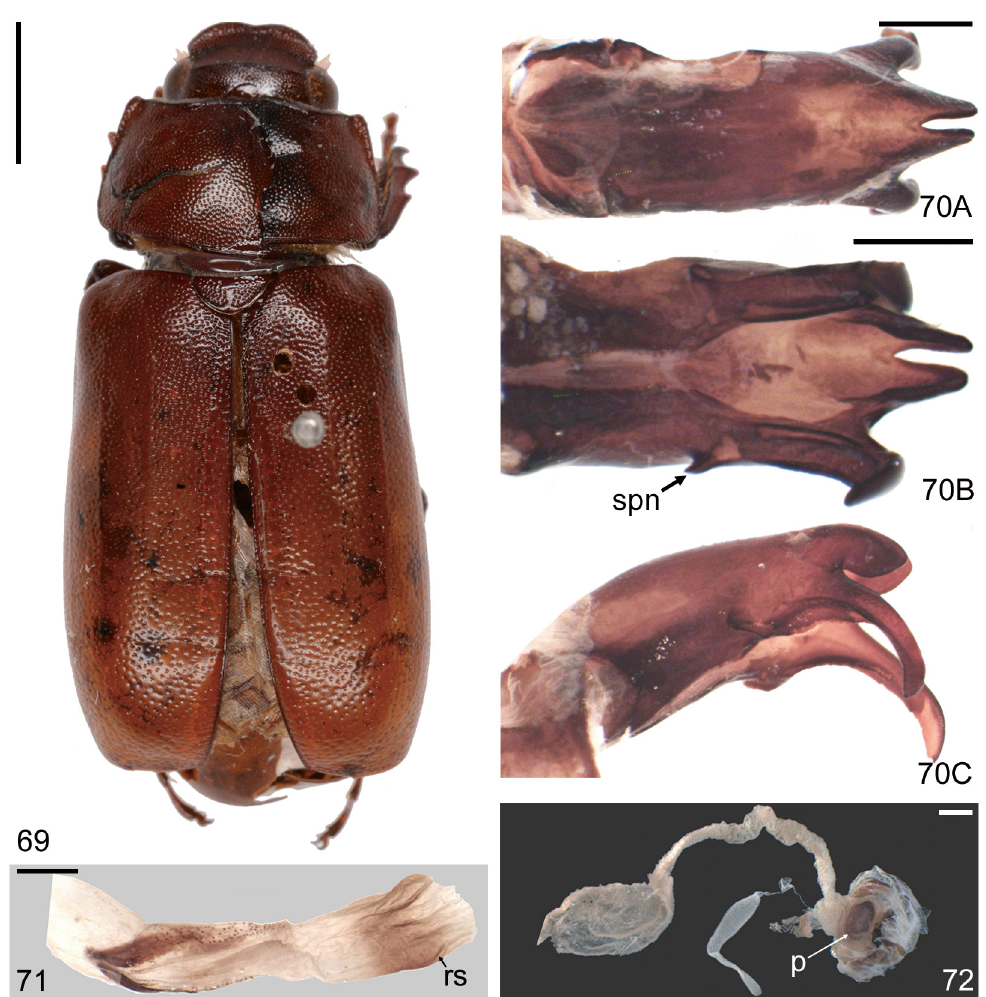
69 . Habitus in dorsal view. 70 . Parameres in dorsal (A), ventral (B) and lateral (C) views. 71 . Endophallus and temones in dorsal view. 72 . Female genitalia, in dorsal view. Scale bars: 69 = 5.0 mm; 70–72 = 1.0